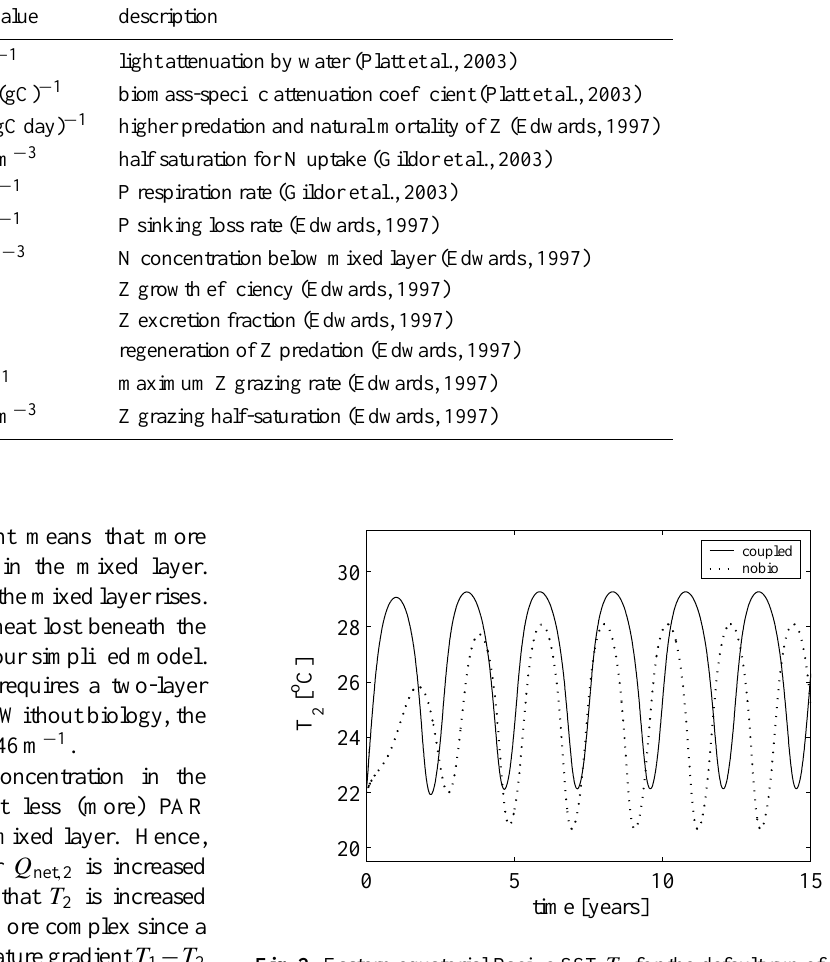
Fig. 2. Eastern equatorial Pacific SST T 2 for the default run of the fully coupled model (solid line, parameters from Tables 1 and 2, k c = 0 . 74m 2 (gC) − 1 ) compared to a run without biology (dotted line, k c = 0 ).